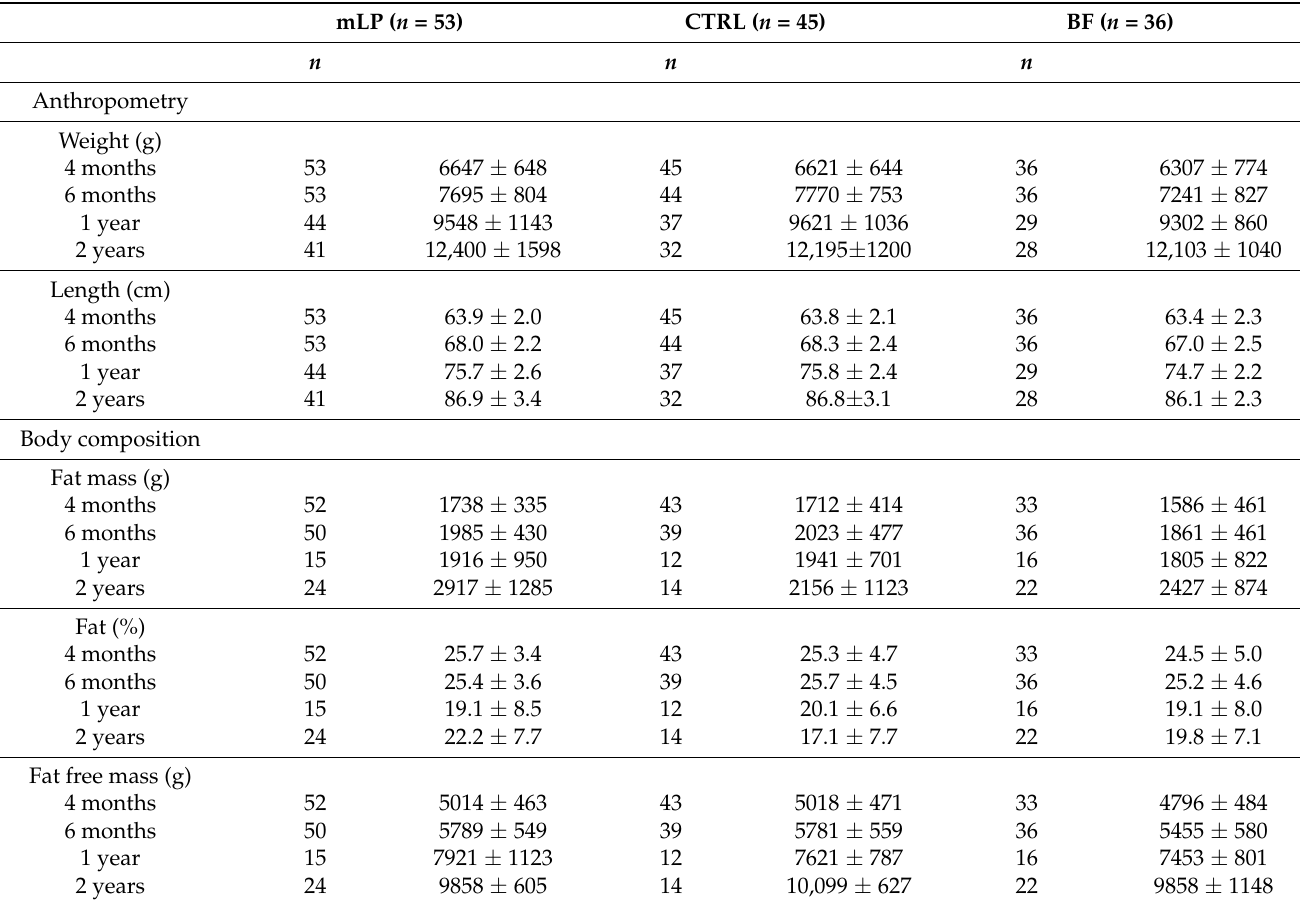
Table 2. Anthropometric parameters at 4 months, 6 months, 1 year, and 2 years of age.